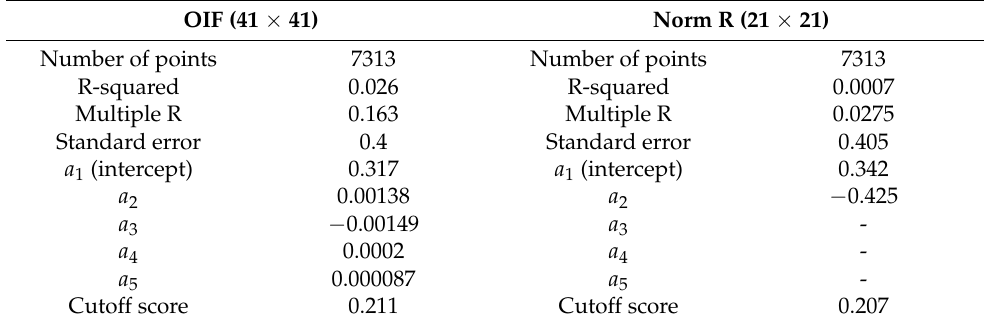
Table 2. Statistics for the linear regression analysis of the optimum index factor (OIF) and norm R dependent and independent